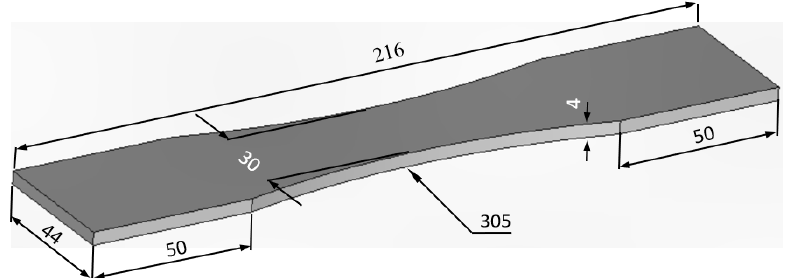
Figure 3. The geometry of the smooth surface dogbone specimen.